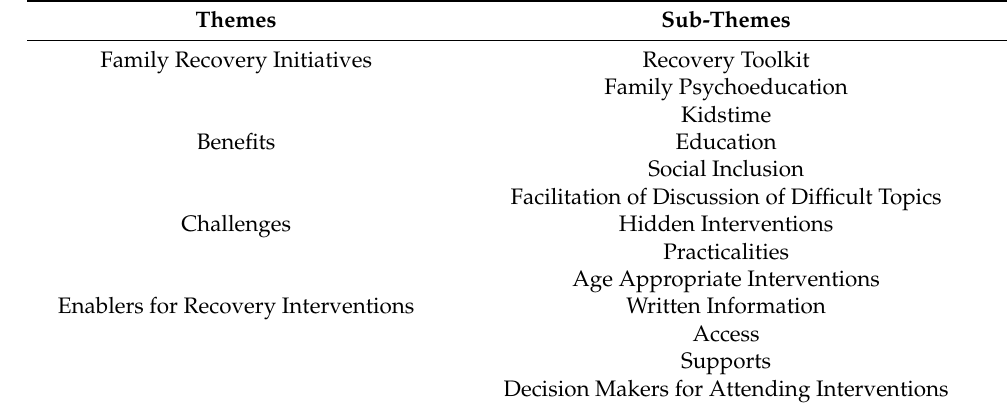
Table 5. Themes and